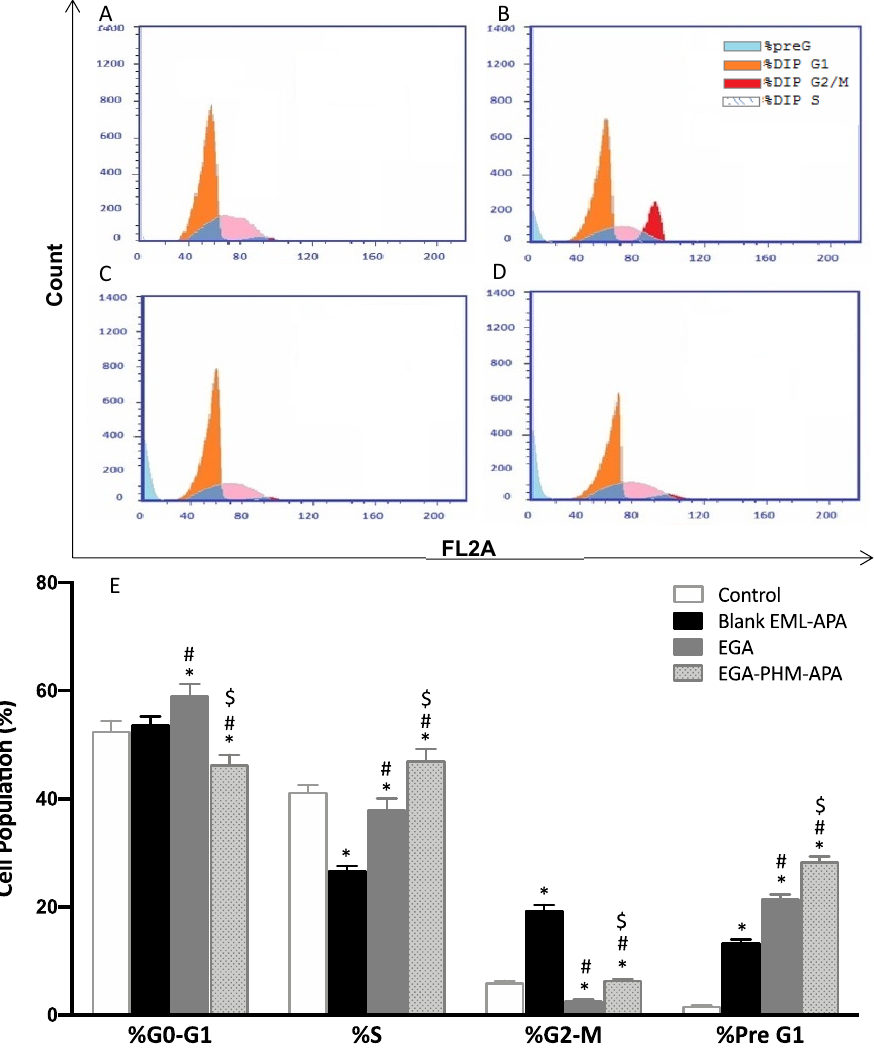
Figure 9. Flow cytometric analysis of MCF-7 control cells ( A ), or treated with blank EML-APA ( B ), EGA ( C ) and EGA-EML-APA ( D ) and the cellular fractions in the phases of the cell cycle ( E ). Data are expressed as mean ± SD. * Significantly different from the control at p < 0.05, # significantly different from blank EML-APA at p < 0.05. $ Significantly different from EGA at p < 0.05. Abbreviations: EGA, ellagic acid; EML, emulsomes; APA, apamin. 2.6. EGA-EML-APA Induced Apoptosis in MCF-7 Cells The increased cellular fraction in the pre-G1 phase strongly indicates that the opti- mized EGA-EML-APA exhibited a significant apoptotic activity. Thus, annexin-V staining was utilized to determine the percentages of apoptotic cells associated with blank EML- APA, EGA and EGA-EML-APA. As can be seen from Figure 10B,C,E, treating MCF-7 cells with EGA-EML-APA formula resulted in the most significant increase in early, late and